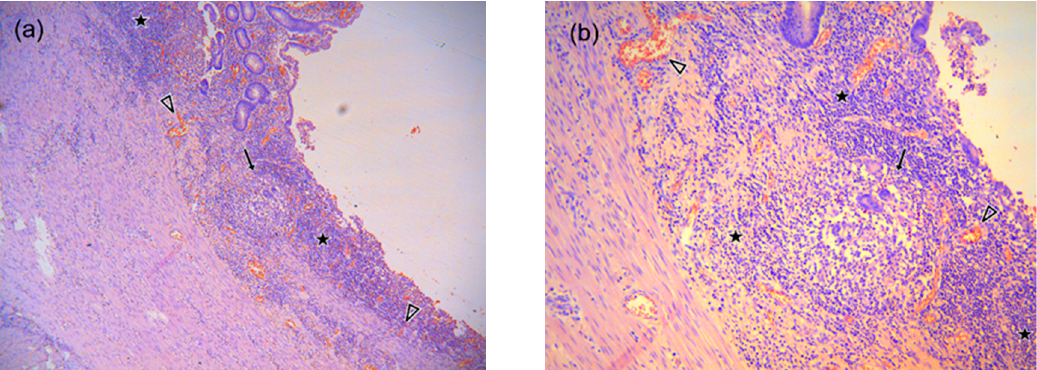
Figure 9. Inflammation of the ileal wall in active chronic CD in 14 y.o. boy, hematoxylin-eosin staining (courtesy of Dr. Ivars Melderis), ( a ) at magnification × 40, ( b ) at magnification × 100. Infiltration by plasma cells, neutrophils and abundant number of lymphocytes is present in the mucosal part of the bowel (star), along with epithelioid granuloma (arrow) in the lamina muscularis mucosae providing additional contribution for restricted diffusion signal in DWI images in children CD. Due to granulation process, there are unaltered red blood cells (arrowheads) in the capillaries of intestinal mucosa. The presence of blood degradation products is not detectable in any of the intestinal wall layers.